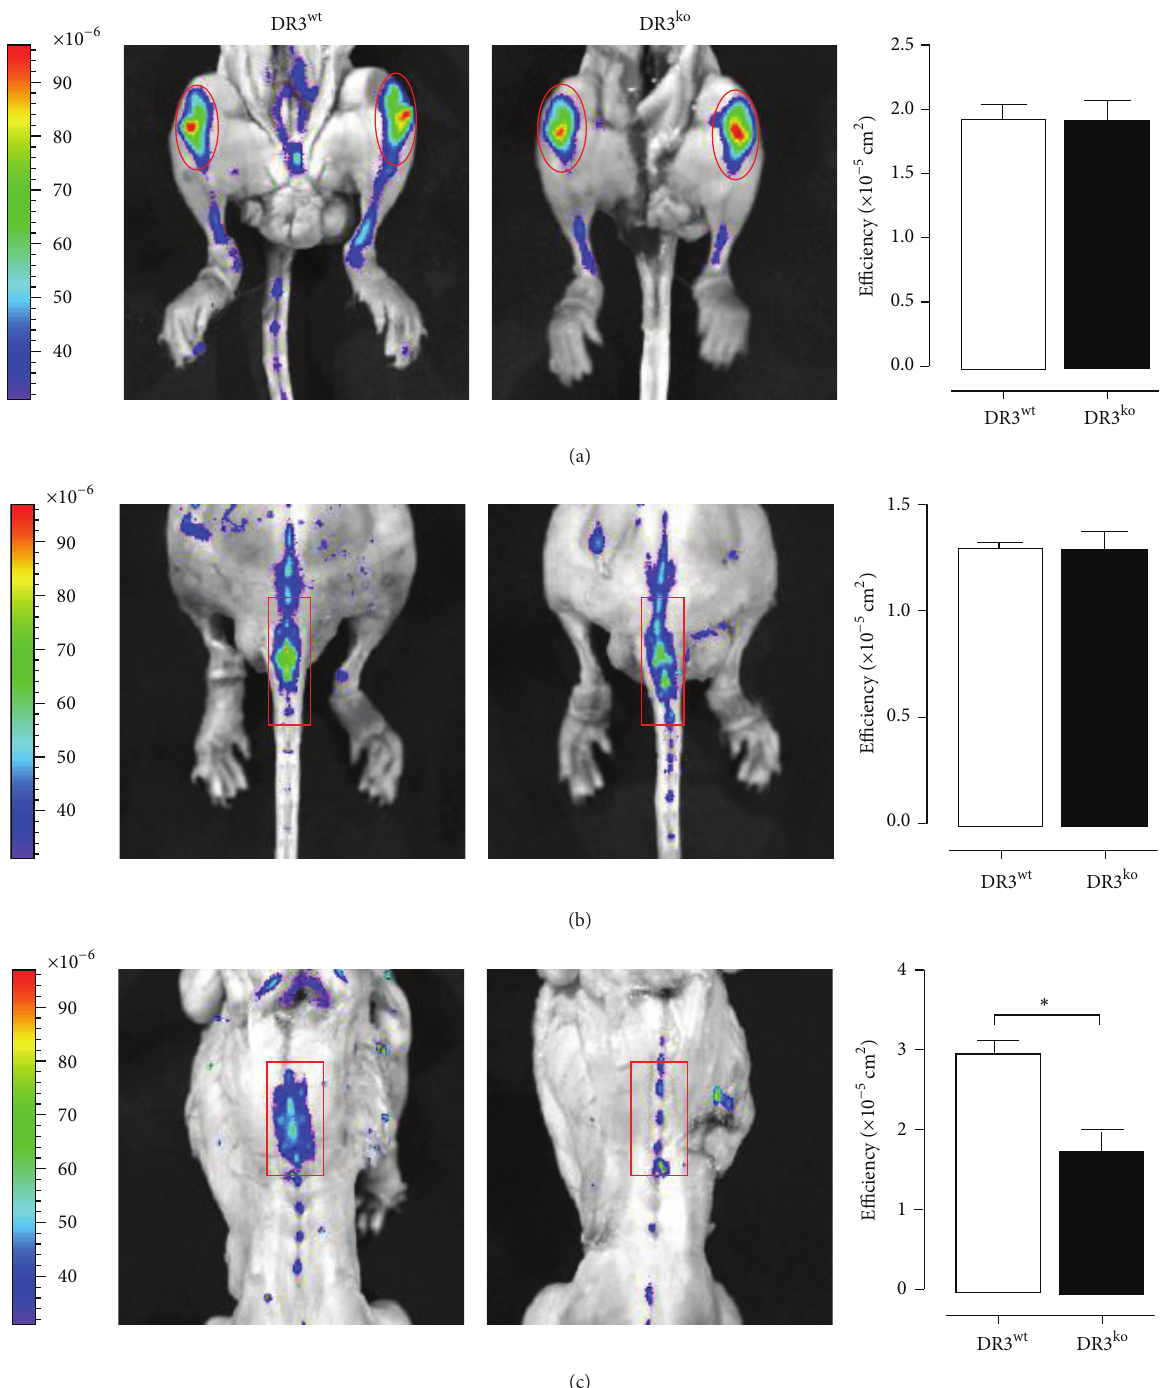
Figure 4: Incorporation of BoneTag into the knee, tail, and thoracic spine of 10-month-old DR 3 wt and DR 3 ko mice (DR 3 wt 𝑛 = 3 , DR 3 ko 𝑛 = 3 ). Mice were injected with the fluorescent probe BoneTag and in vivo bone formation was analyzed. No differences in bone formation were observed in the (a) knee or (b) tail. A significant increase in bone formation was observed in the (c) thoracic spine of DR 3 wt compared to DR 3 ko mice ( 𝑃 ≤ 0.05 ). Area quantified illustrated by red